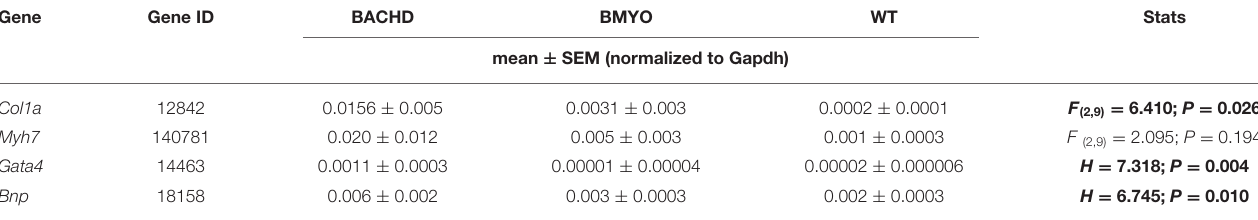
TABLE 2 | expression levels of selected genes in the hearts of BACHD, BMYO and WT animals at 6 months of age. Gene Gene ID BACHD BMYO WT Stats mean ± SEM (normalized to Gapdh) Col1a 12842 0.0156 ± 0.005 0.0031 ± 0.003 0.0002 ± 0.0001 F (2,9) = 6.410; P = 0.026 Myh7 140781 0.020 ± 0.012 0.005 ± 0.003 0.001 ± 0.0003 F (2,9) = 2.095; P = 0.194 Gata4 14463 0.0011 ± 0.0003 0.00001 ± 0.00004 0.00002 ± 0.000006 H = 7.318; P = 0.004 Bnp 18158 0.006 ± 0.002 0.003 ± 0.0003 0.002 ± 0.0003 H = 6.745; P =